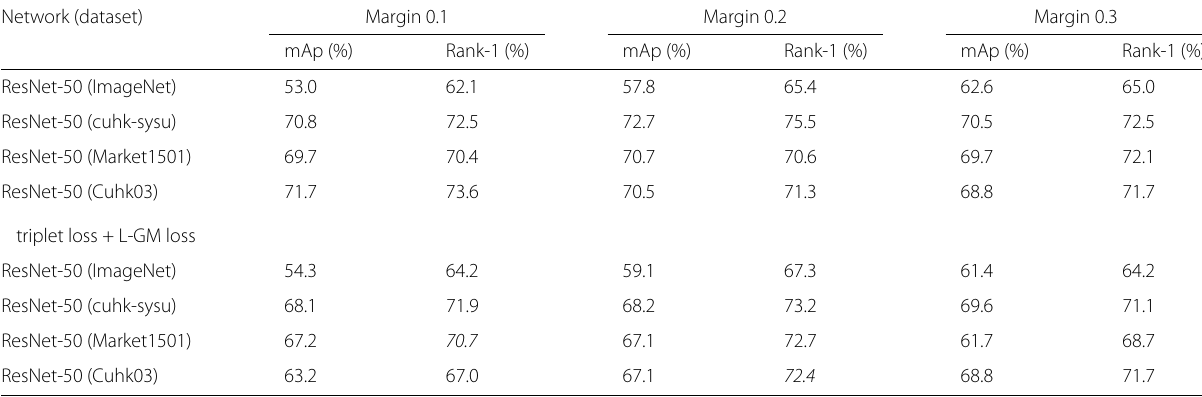
Table 1 For dataset evaluation, we use the ResNet-50 with triplet loss function and the proposed model with a combination of different loss functions Network